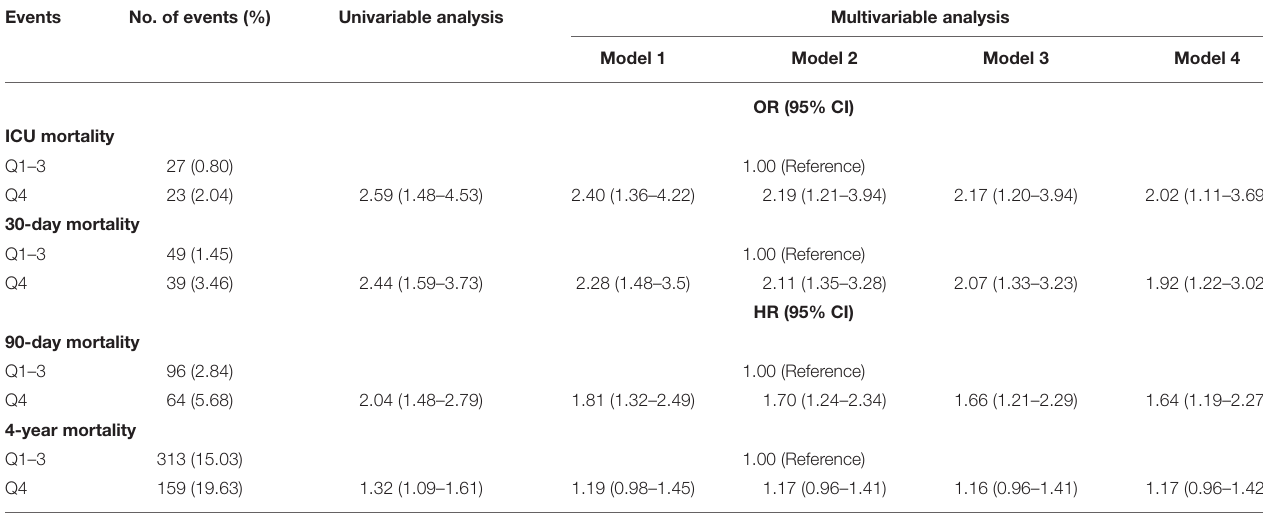
TABLE 2 | Association between the highest quartile (Q4) vs. Q1–3 for the coefficient of variation of SBP within the first 24h of post-operative ICU admission and mortality. Events